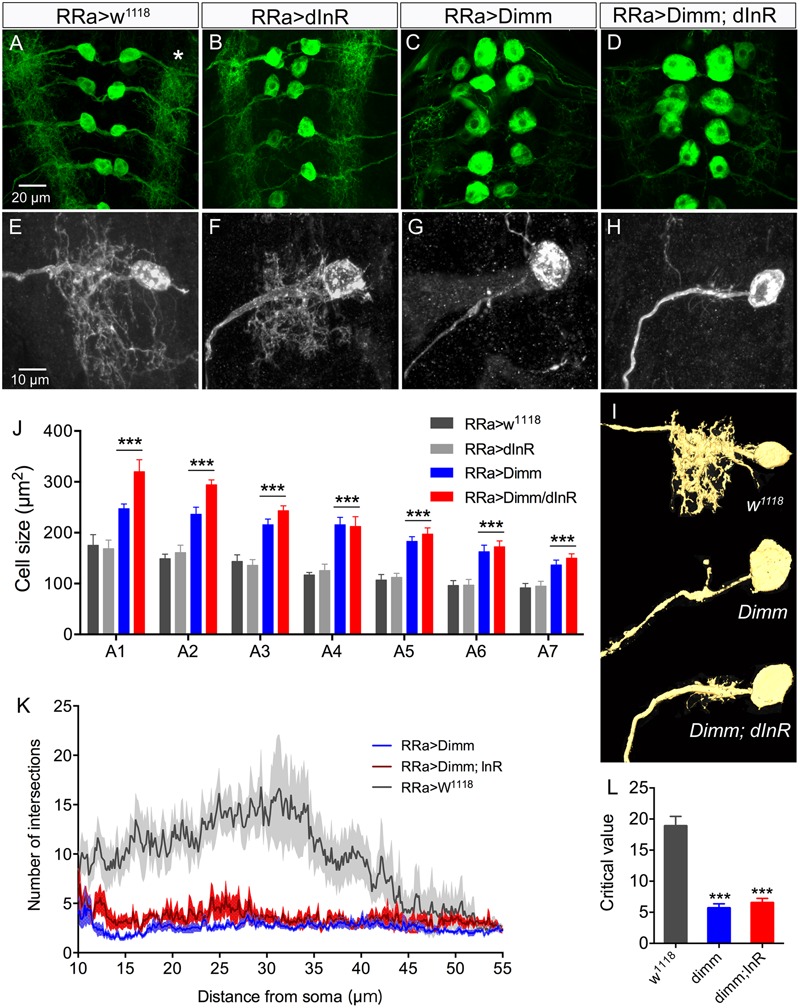
Ectopic expression of Dimm induces growth of aCC cell bodies and loss of growth of their dendrites. (A–D) The size of the aCC cell bodies is increased by ectopic expression of Dimm and Dimm combined with insulin receptor (Dimm; dInR), but not by dInR alone (visualized by RRa; GFP and anti-GFP). (E–H) The dendrites of the aCC neurons in abdominal segment A4 are reduced after expression of Dimm (G) and Dimm; dInR (H). These images are obtained by utilizing an RN2-FLP construct and mild heat shock late in the embryo to generate small, random subpopulations of aCC/RP2 neurons for driving Dimm and Dimm+dInR expression (visualized by red fluorescent protein). (I) Amira renderings of representative aCC neurons from A4 showing the ipsilateral dendrites. Note that in A4 the additional effect of dInR expression is negligible. (J) Quantification of cell body sizes after ectopic expression of Dimm or Dimm+dInR compared to controls and dInR alone. Abdominal segments A1–A7 were analyzed; both Dimm and Dimm+dInR expression induced significantly increased cell bodies in all segments compared to RR > w1118 and RRa > dInR crosses (∗∗∗p < 0.001, as assessed by two way ANOVA followed by Tukey’s multiple comparisons test). The additional effect of combined ectopic dInR and Dimm compared to ectopic dimm alone (blue to red bars) was only significant in A1 and A2 (p < 0.05 for A1 and p < 0.01 for A2 for A2 as assessed by unpaired t-test). Data are presented as means ± SEM; with 9–12 larvae from three biological replicates. (K) Sholl profiles of dendrite density, measured between 10 and 55 μm from the cell body (soma). Number of intersections for dendrite of aCC neurons after Dimm and Dimm+dInR expression were much fewer than control larvae. (L) The peak of maximum branch density was determined by critical value (Ristanovic and Milosevic, 2007), it was significantly reduced after Dimm and Dimm+dInR expression. Data are presented as means ± SEM; with 7–8 larvae from three biological replicates (∗p < 0.05, ∗∗∗p < 0.001, ns, not significant), as assessed by Mann–Whitney test after Shapiro–Wilk normality test.